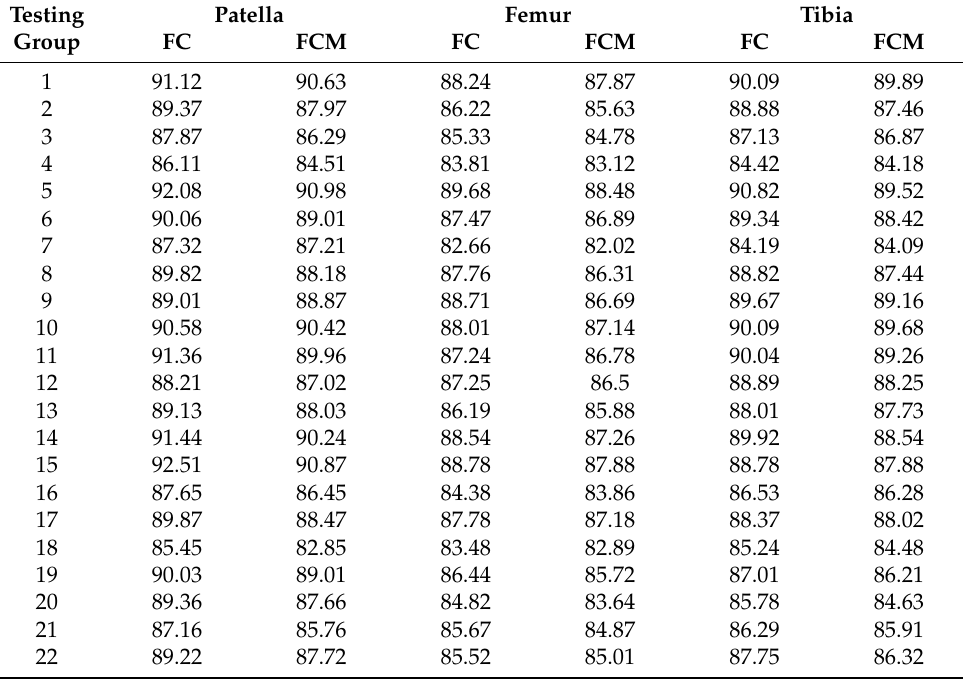
Table 5. Dice index values for the analyzed CT series, for the FC and FCM